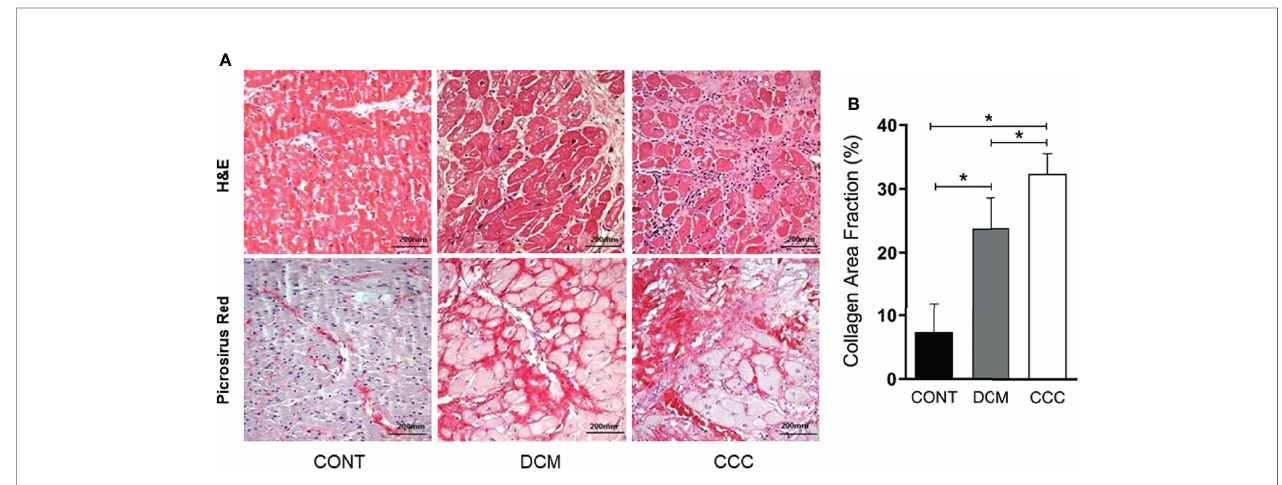
FIGURE 1 | Histopathological features of myocardial samples. (A) Slides of hematoxylin – eosin (H&E) and picrosirius red stained myocardial sections of representative patients with CCC, DCM and individuals without cardiomyopathies (Controls). Representative heart sections were shown with magni fi cation: ×20. Myocardial hypertrophy characterized by fi ber and nuclear enlargement is evident in the CCC and DCM groups. Diffuse mononuclear or lymphocytic myocarditis is present only in the CCC group. Interstitial fi brosis stained in red with picrosirius red is present in the CCC and DCM groups. (B) The severity of fi brosis was quanti fi ed by collagen area fraction (%) in DCM and CCC group exhibit a signi fi cant increase in the deposition of collagen. Groups were compared by a non-parametrical test (Mann – Whitney Rank Sum Test) with GraphPad Prism software (version 6.0; GraphPad). Results were expressed as mean ± SD. *P -values were considered signi fi cant if p-value (0.05) corrected for multiple comparisons by Bonferroni ’ s method (corrected p-value = 0.05/3 =